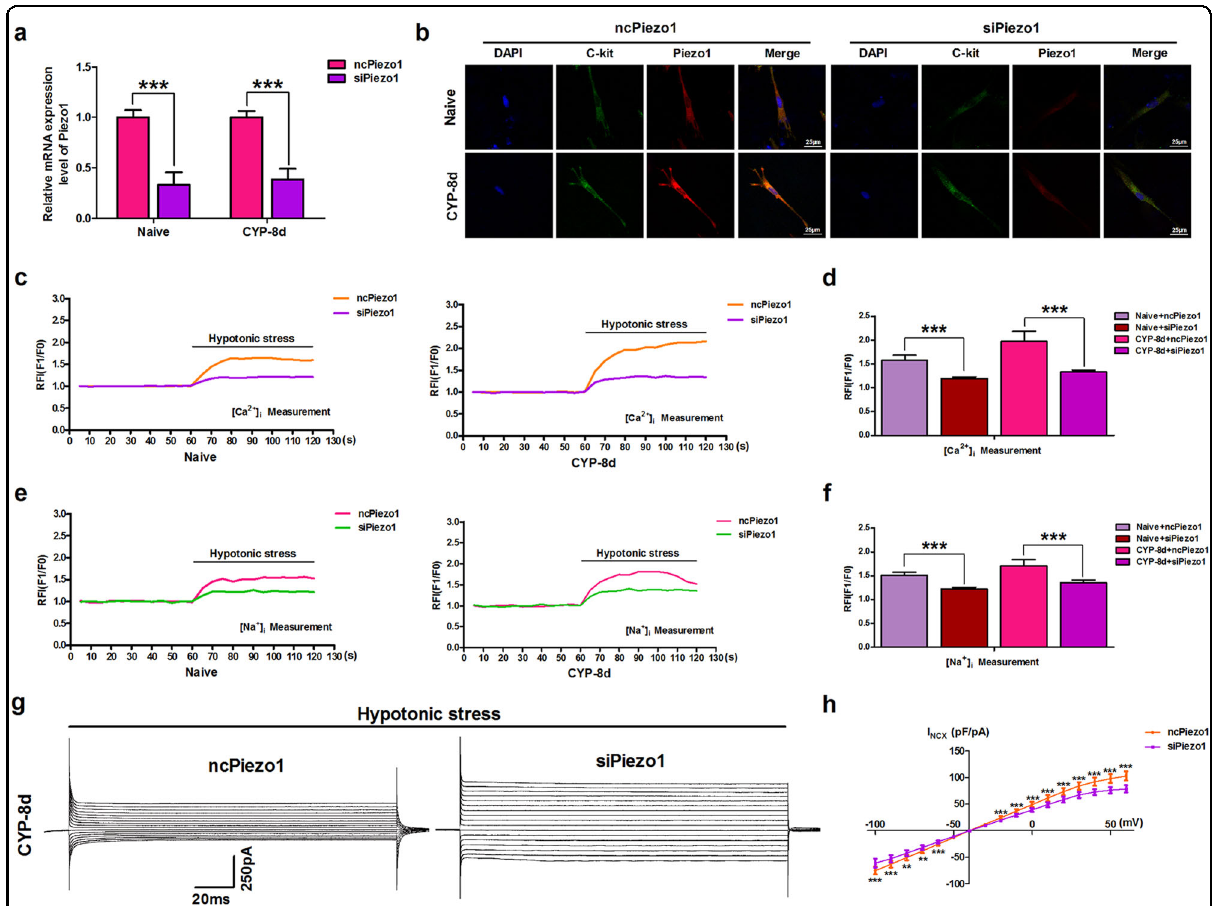
Fig. 7 siPiezo1 signi fi cantly decreased [Ca 2 + ] i and [Na + ] i and the I NCX density in bladder ICC-LCs from CYP-8d rats. a Compared with the negative control, control siRNA (ncPiezo1) and siRNA targeting the Piezo1 channel (siPiezo1) signi fi cantly knocked down Piezo1 channel mRNA expression by >60% in cultured bladder cells (the data represent the mean ± S.D., n = 3; *** P < 0.001, versus ncPiezo1). b siPiezo1 also remarkably decreased Piezo1 channel protein expression (red) in bladder c-kit (green)-positive ICC-LCs (white arrows) from naive and CYP-8d rats. c – f In bladder ICC-LCs from naive and CYP-8d rats, siPiezo1 signi fi cantly attenuated the hypotonic stress-induced increases in [Ca 2 + ] i and [Na + ] i . These siPiezo1- induced reductions were most prominent in bladder ICC-LCs from CYP-8d rats (the data represent the mean ± S.D., n = 10; *** P < 0.001, versus ncPiezo1). g , h Under hypotonic conditions, I NCX was recorded in ncPiezo1- or siPiezo1-treated bladder ICC-LCs from CYP-8d rats. siPiezo1 signi fi cantly decreased the absolute value of the I NCX density. siPiezo1-induced decreases in the reverse mode of NCX ( − 20 to + 60 mV), and these reverse mode decreases were more obvious than those in the forward mode of NCX ( − 100 to − 60 mV) (the data represent the mean ± S.D., n = 8; * P < 0.05, ** P < 0.01, and *** P < 0.001, versus